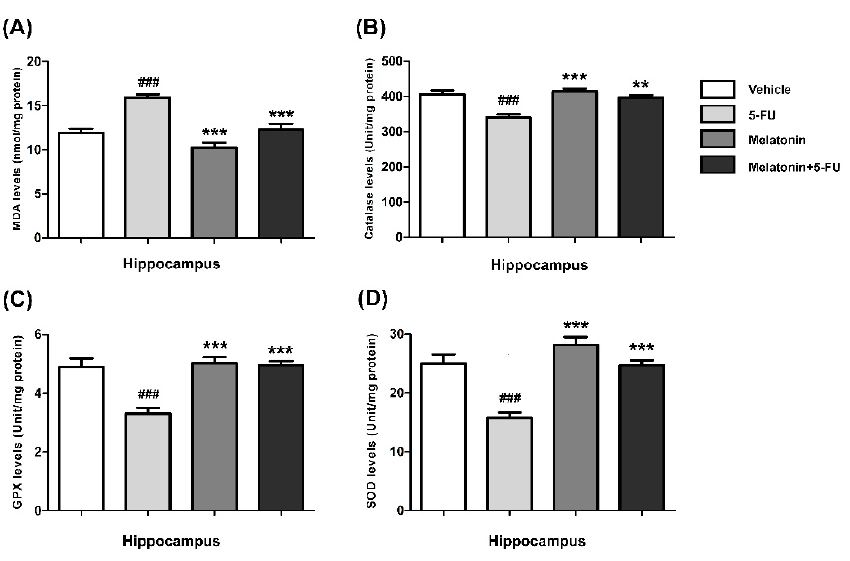
Figure 3. MDA ( A ), CAT ( B ), GPX ( C ) and SOD ( D ) levels in the hippocampus. ### p < 0.001 compared with the vehicle group. ** p < 0.01 and *** p < 0.001 compared with the 5-FU group. Malondialdehyde: MDA; catalase: CAT; glutathione peroxidase: GPX; superoxide dismutase: SOD.